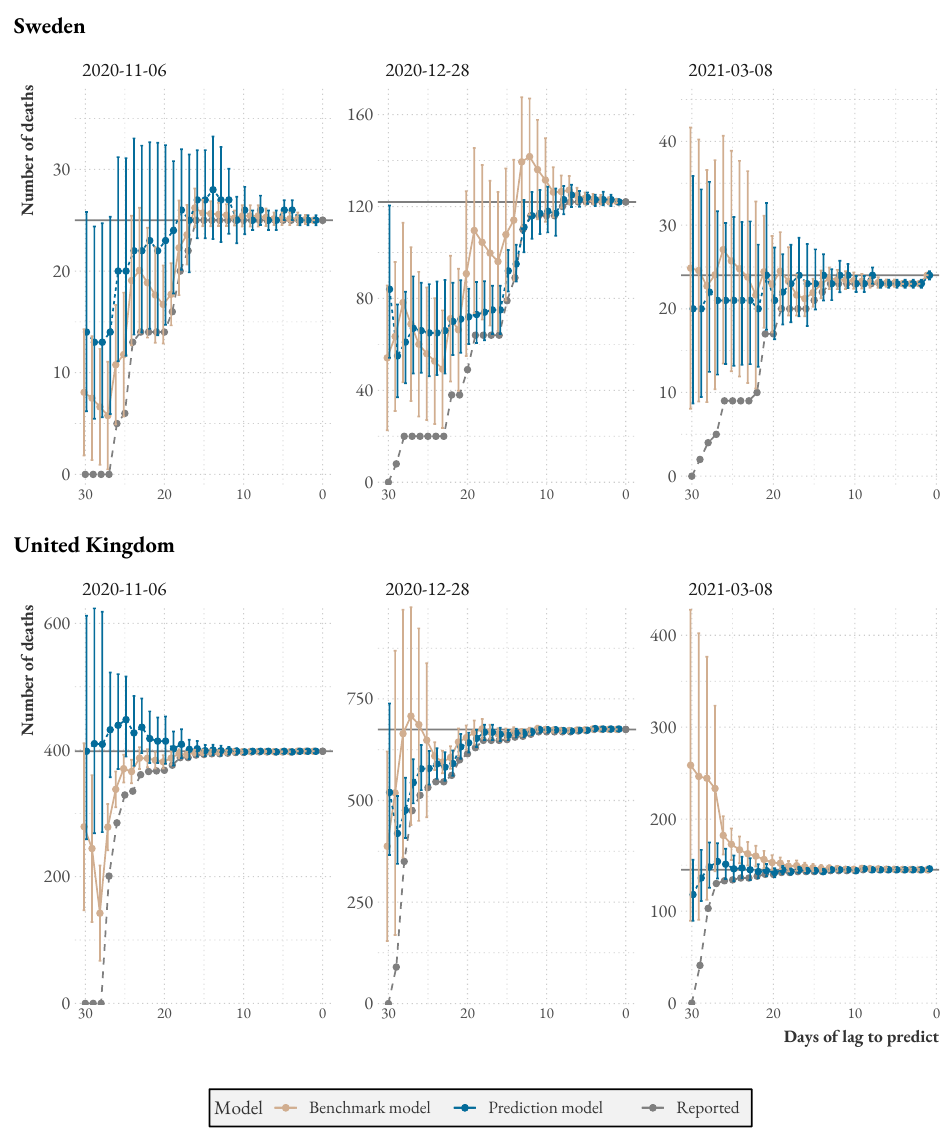
Figure 3. Model accuracy over time for three randomly chosen dates, compared to the constant benchmark. The gray dots indicate the actual number of reported dead until that point in time. The solid line indicates the total number that will have been reported after 30